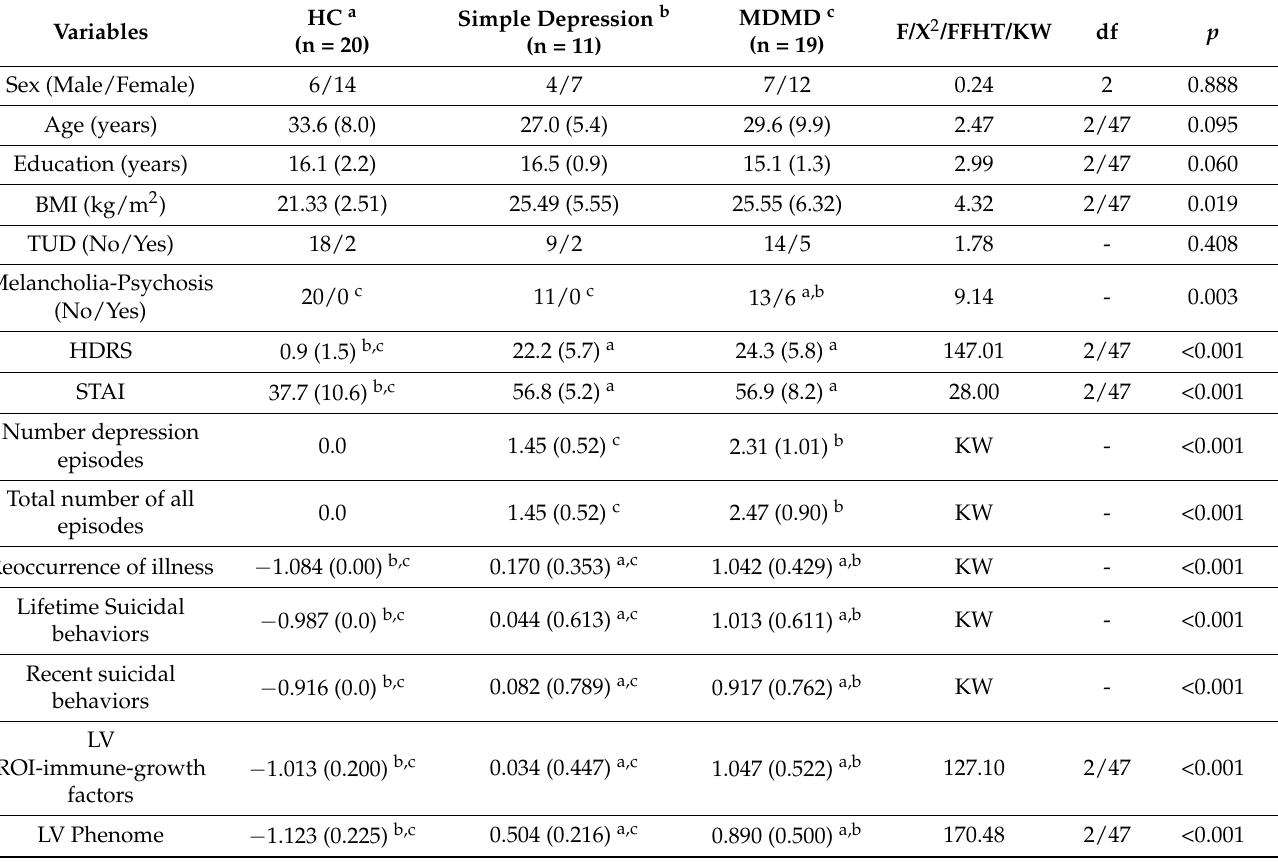
Table 1. Demographic and clinical data of the healthy controls (HC) and depressed patients divided into those with simple depression and major dysmood disorder